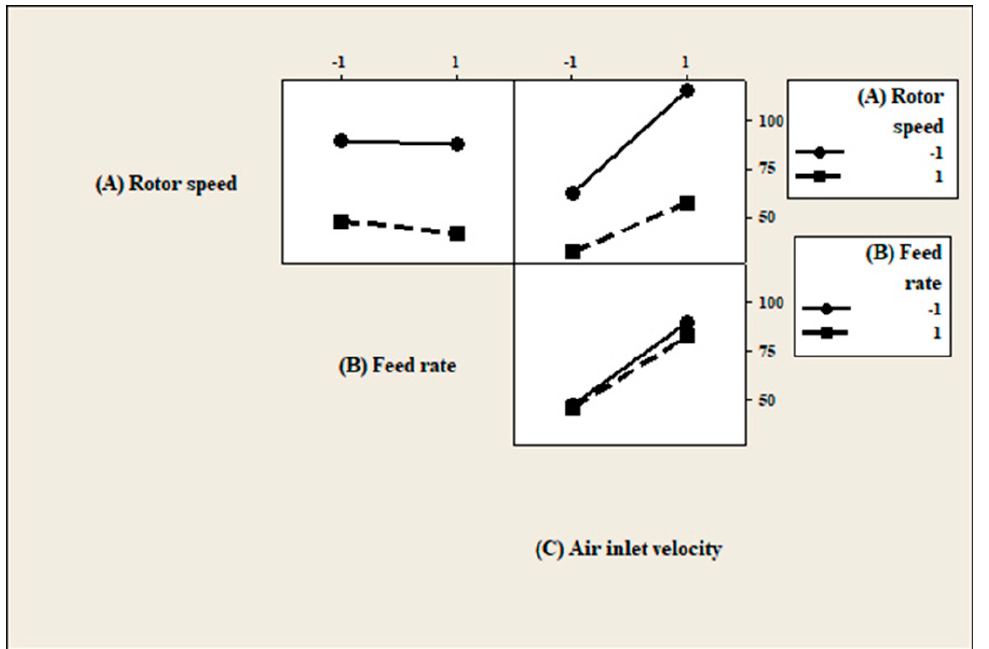
Figure 7. Interaction effects plot for cut size.